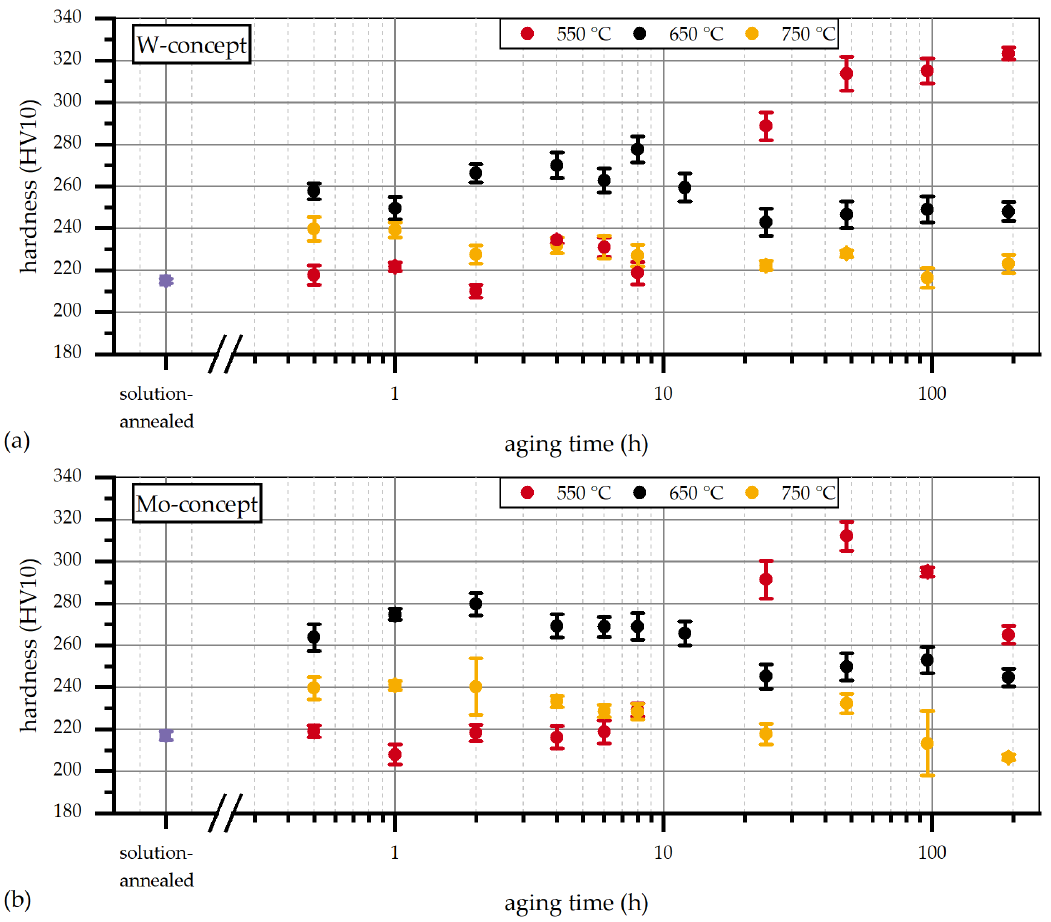
Figure 5. ( a , b ) Hardness vs. aging time at 550, 650, and 750°C for both alloying concepts. The composition of the matrix as a function of aging time can be taken from Table 3. It is demonstrated that with the increasing holding time, the matrix is depleted of Nb and W in the W-concept and of Nb and Mo in the Mo-concept. While Mo was removed from the matrix already after 4 h, the depletion of W in the matrix occurred only after 12 h. Table 3. Matrix composition (wt. %) in dependency of the aging time at 650°C for both alloying concepts measured by EDS. Aging Alloy Aging Temperature